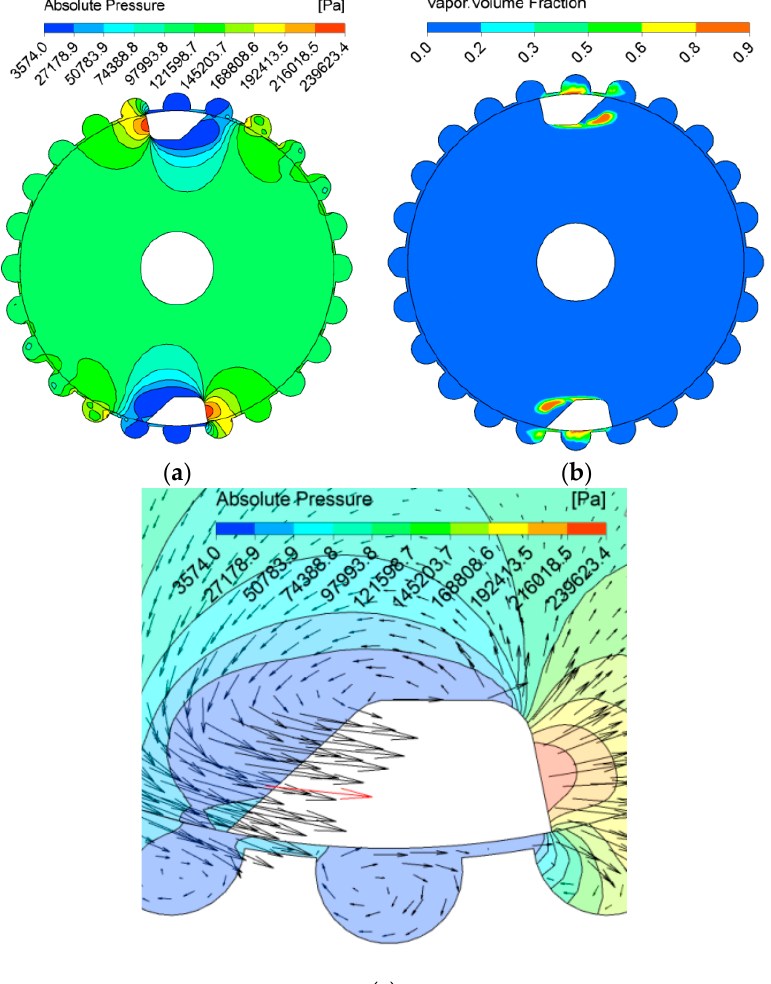
Figure 12. Sectional flow distribution of cutter. ( a ) Static pressure distribution, ( b ) Vapor volume fraction distribution, ( c ) Absolute velocity near the cutter head vector illustration.